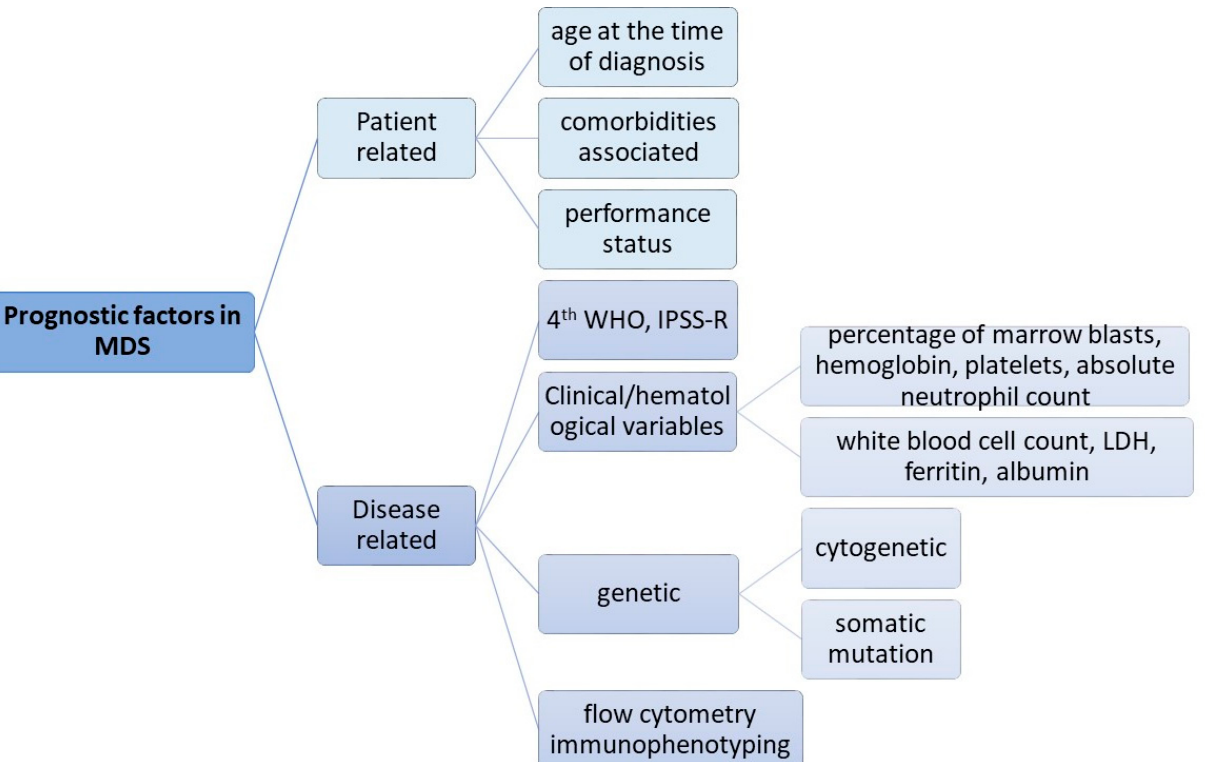
Figure 1. Prognostic factors in MDS (WHO—World Health Organization classification; IPSS-R— Revised International Prognostic Scoring System; LDH—lactate dehydrogenase).